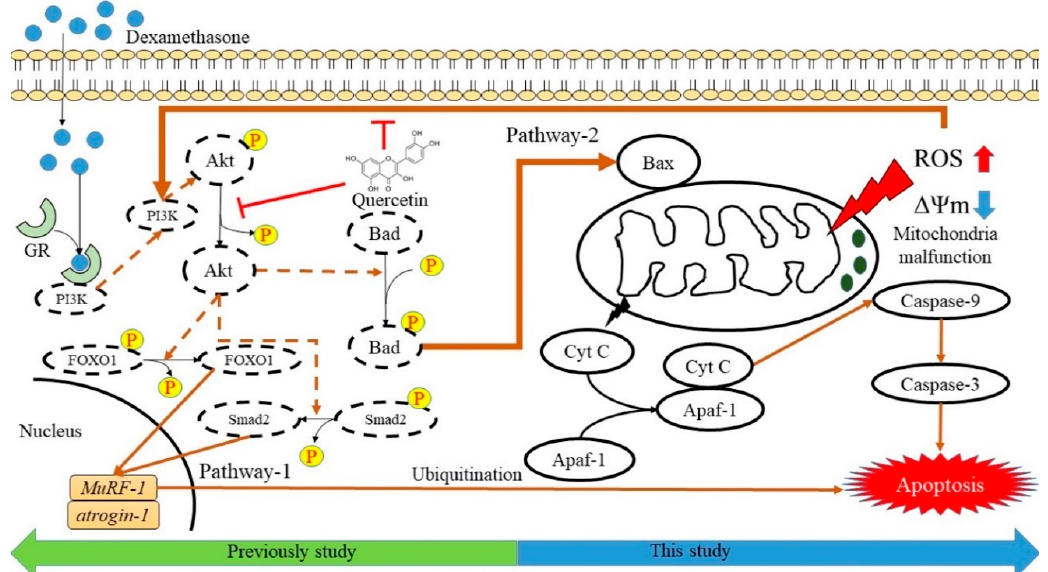
Figure 6. Possible antioxidant signaling pathways regulating dexamethasone-induced muscle apoptosis by quercetin. Pathway-1 was described in previous studies as the PI3K/Akt pathway [12], and pathway-2 was demonstrated in our study to regulate mitochondrial caspase-dependent apoptosis.